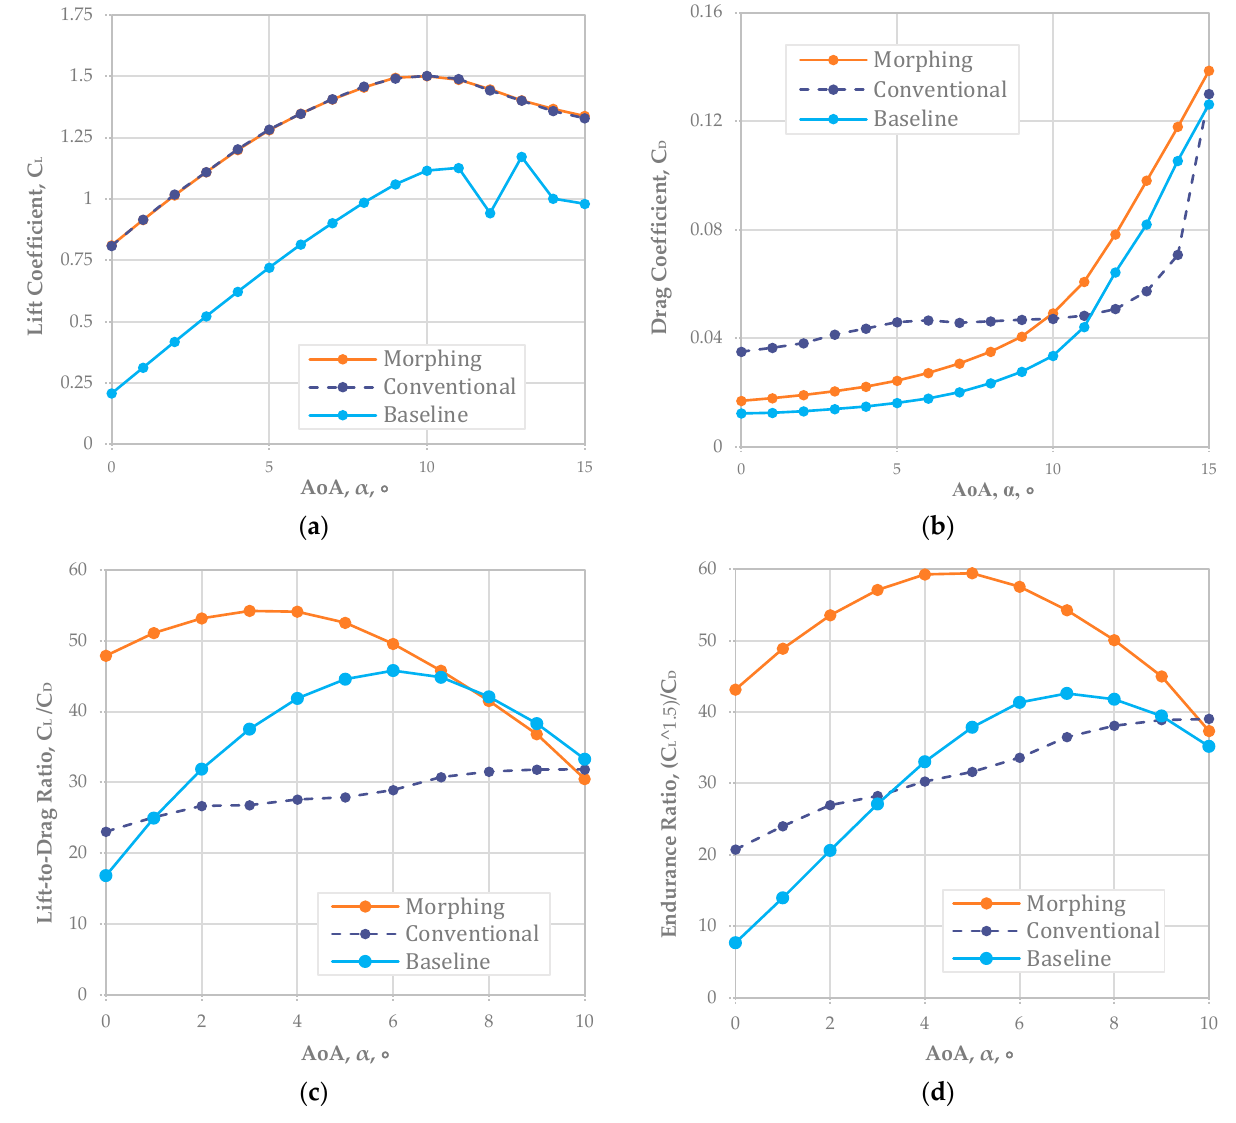
Figure 5. Matching 𝐶 (cid:3013) morphing (NACA 8410) and conventional airfoil plots (Re = 778,179): ( a ) 𝐶 (cid:3013) ; Figure 5. Matching C L morphing (NACA 8410) and conventional airfoil plots (Re = 778,179): ( a ) C L ; ( b ) 𝐶 (cid:3005) ; ( c ) 𝐶 (cid:3013) /𝐶 (cid:3005) ; ( d ) endurance ratio. ( b ) C D ; ( c ) C L / C D ; ( d ) endurance ratio. Table 5. Comparison of the L / D or C L / C D of morphing and conventional